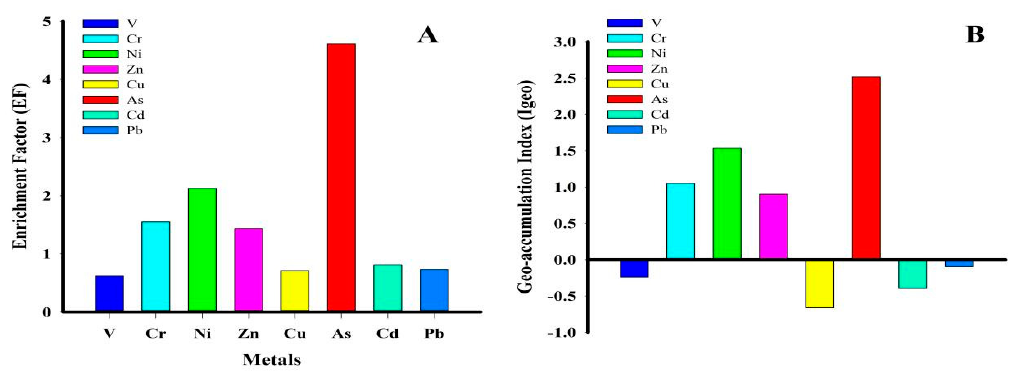
Figure 2. ( A ) Metals enrichment factors (EF); ( B ) geo-accumulation index (Igeo).